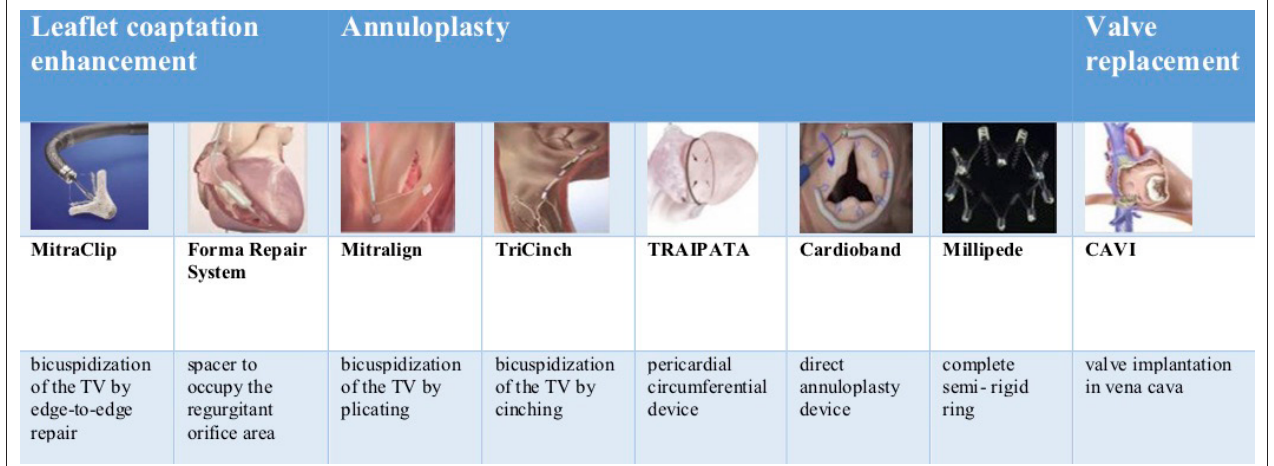
FiguRe 1 | Overview over new tricuspid valve repair devices. CAVI, caval valve implantation; TV, tricuspid valve; TRAIPTA, transatrial intrapericardial tricuspid